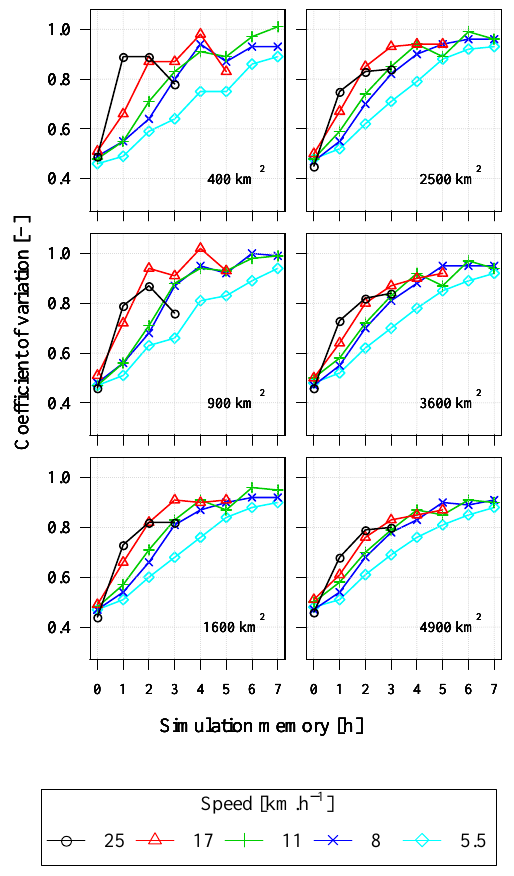
Fig. 13. Sensitivity analysis. Coefficient of variation (CV J ) for dif- ferent catchment sizes and advection